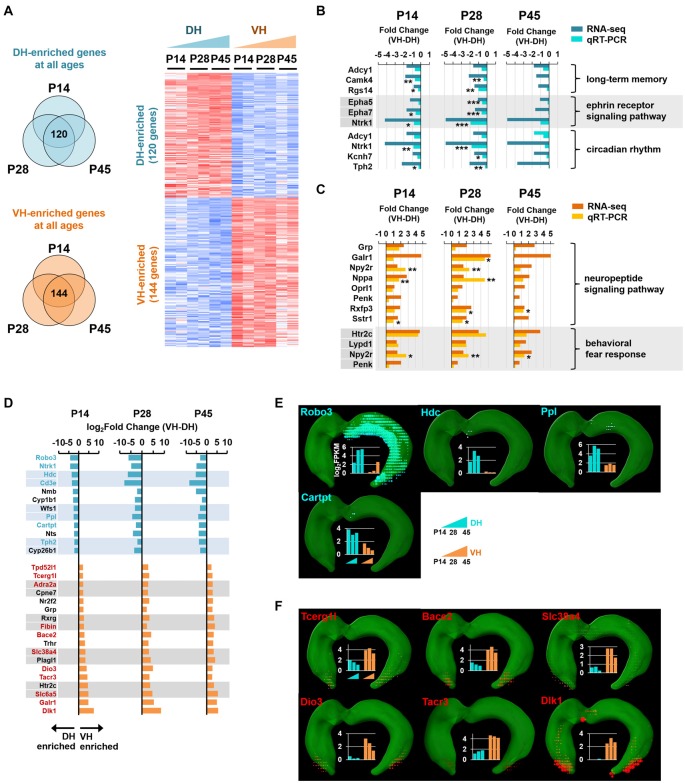
Analysis of enriched genes at all three developmental ages in the dorsal and ventral hippocampus. (A) Genes with a fold change of VH to DH ≥1.5 or ≤−1.5 at all developmental stages (P14, P28 and P45) were defined as ventrally or dorsally enriched genes, respectively. Heatmap for the dorsally or ventrally enriched genes. Refer to Supplementary Table S2 for the full gene list. (B) qRT-PCR validations for the genes belonging to the GO terms, long-term memory (Adcy1, Camk4, Rgs14), ephrin receptor signaling pathway (Epha5, Epha7, Ntrk1) and circadian rhythm (Adcy1, Ntrk1, Kcnh7, Tph2) targeted by the dorsally enriched genes at all three developmental ages (P14, P28, and P45) n = 3–5 independent samples. *p < 0.05, **p < 0.005, ***p < 0.0005 VH compared with DH, Student’s t test. Refer to Supplementary Table S5 for detailed statistics, including n number, t-value, degree of freedom and p-value for individual genes. Also refer to Supplementary Figure S5A. (C) qRT-PCR validations for the genes belonging to the GO terms, neuropeptide signaling pathway (Grp, Galr1, Npy2r, Nppa, Oprl1, Penk, Rxfp3, Sstr1), and behavioral fear response (Htr2c, Lypd1, Npy2r, Penk) targeted by the ventrally enriched genes at all three developmental ages. Refer to Supplementary Figure S5B. n = 3–5 independent samples. *p < 0.05, **p < 0.005 VH compared with DH, Student’s t test. Refer to Supplementary Table S5 for detailed statistics, including n number, t-value, degree of freedom and p-value for individual genes. (D) Genes with a fold change of VH to DH ≥4.0 or ≤−4.0 at all three developmental stages (P14, P28 and P45) are selected as ventrally or dorsally highly enriched genes, respectively. The gene names are presented on the left side of the graphs; genes in cyan and red font indicate newly identified potential markers for the dorsal and ventral hippocampus, respectively. (E,F)
In situ hybridization data obtained using ABA Brain Explorer 2. Among the potential novel marker genes in (D), only those that were validated by the ABA in situ hybridization data were presented as novel dorsal (E) and ventral (F) hippocampal markers. Graphs represent RNA-seq data; y-axis indicates the value of log2FPKM. Note that RNA-seq and qRT-PCR data were obtained from rat samples, whereas ABA in situ hybridization data were obtained from mouse samples.